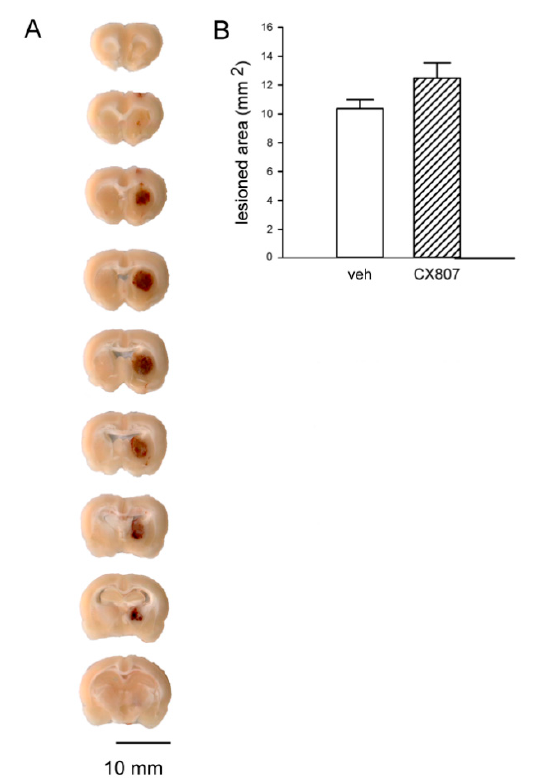
Figure A1. Intracerebral administration of collagenase induced ICH in striatum. ( A ) Brain tissue was collected, sectioned (at 1-mm thickness), and PFA -fixed at 4 days after administration of collagenase (0.5 unit / µ L × 2 µ L). Cerebral hemorrhage (brown color) was found in the ipsilateral striatum. ( B ) Brain samples were also cut at a 30- µ m thickness on a cryostat. Slices were rinsed in PB, mounted on slides, and cover-slipped. The area of lesion (tissue loss after rinsing with PB) was analyzed in brain sections with visible anterior commissure. CX807 did not significantly alter the lesioned area ( p = 0.204, t test).